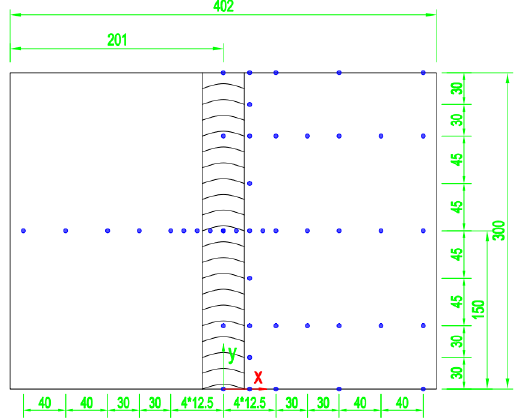
Figure 8. Measuring points on surface A (unit mm).